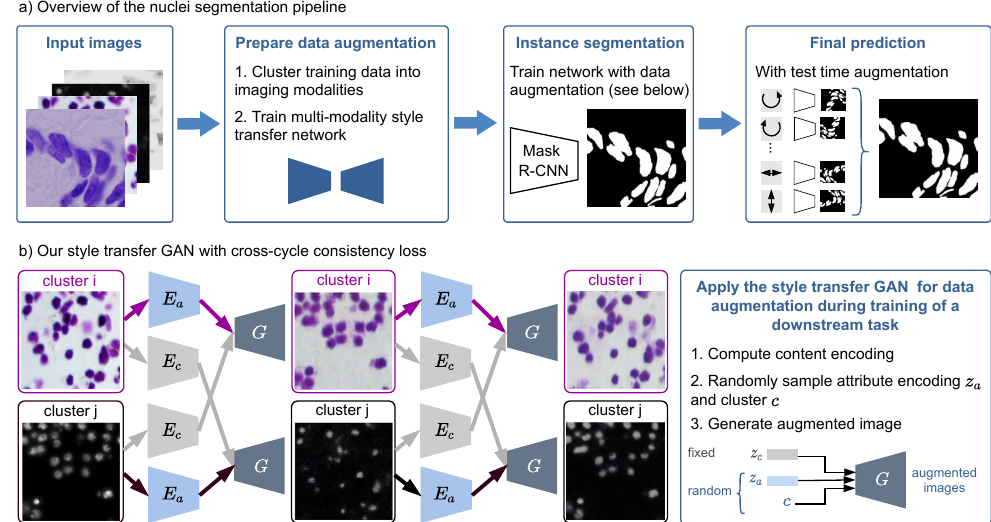
Figure 1. ( a ) Overview of our nuclei segmentation pipeline with multi-modality style transfer as data augmentation, Mask R-CNN as instance segmentation network, and test time augmentation for the final prediction. ( b ) Our style transfer GAN is trained with a cross-cycle consistency loss that does not need paired data. The right box shows how it is applied for data augmentation during training of the nuclei segmentation network.